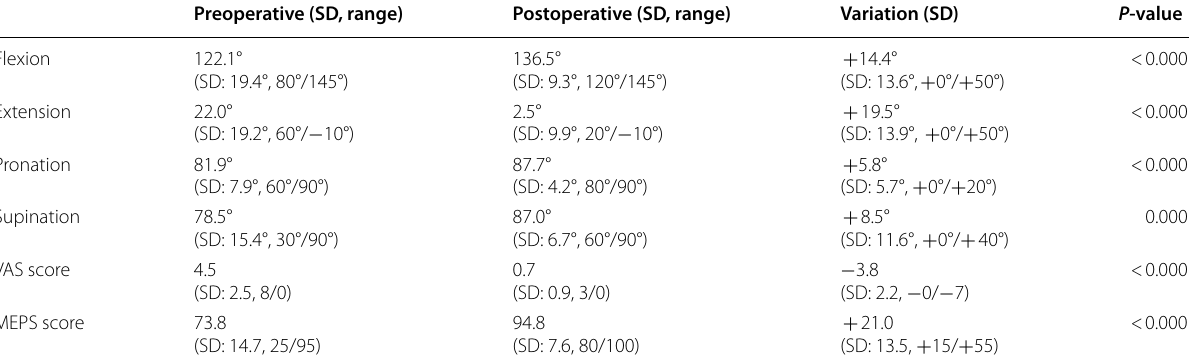
Overall clinical outcomes of the study population. The first four lines report the basic movements of the elbow: flexion, extension, pronation, and supination (in degrees). The last two lines show the VAS score and the MEPS score in points. For each element, the preoperative and postoperative means (with SD standard deviation and range with minimum / maximum value obtained), the variation, and the P -value are reported